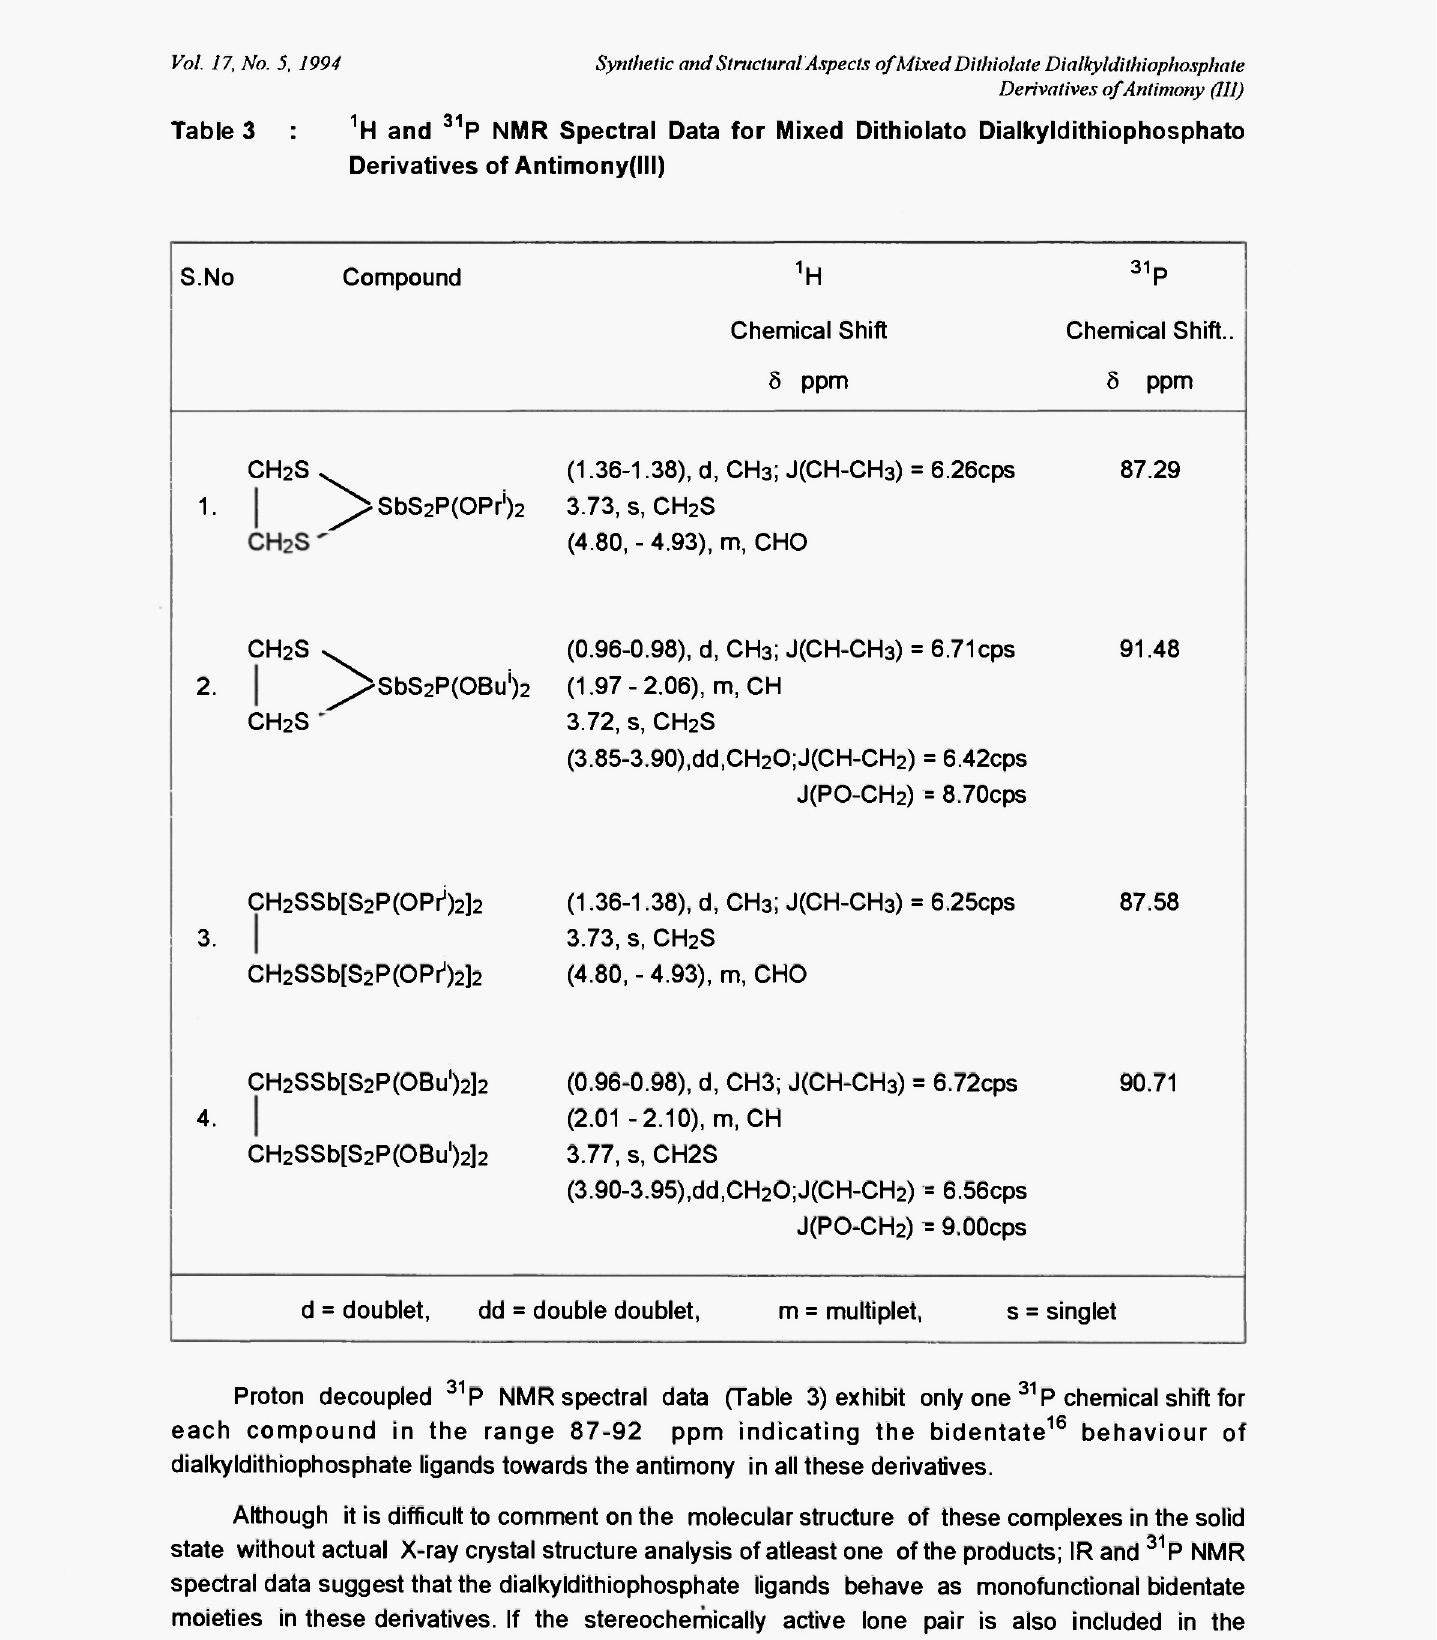
1 H and 31 P NMR Spectral Data for Mixed Dithiolato Dialkyldithiophosphato Derivatives of